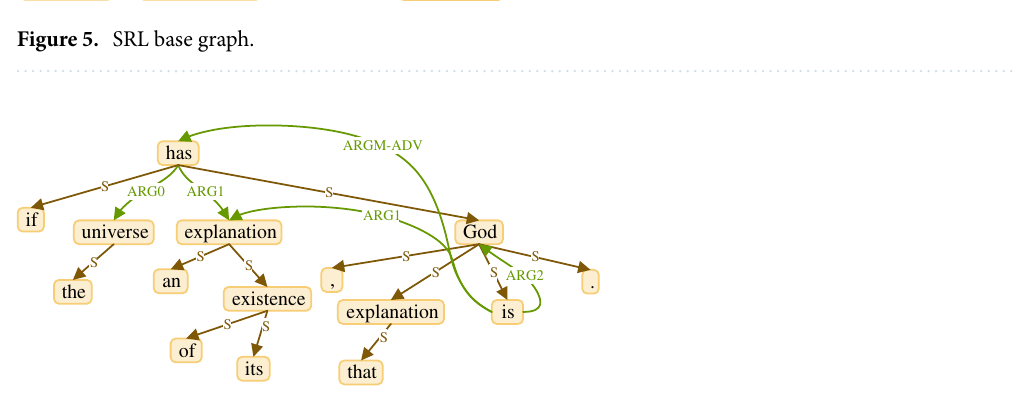
Figure 5. SRL base graph.